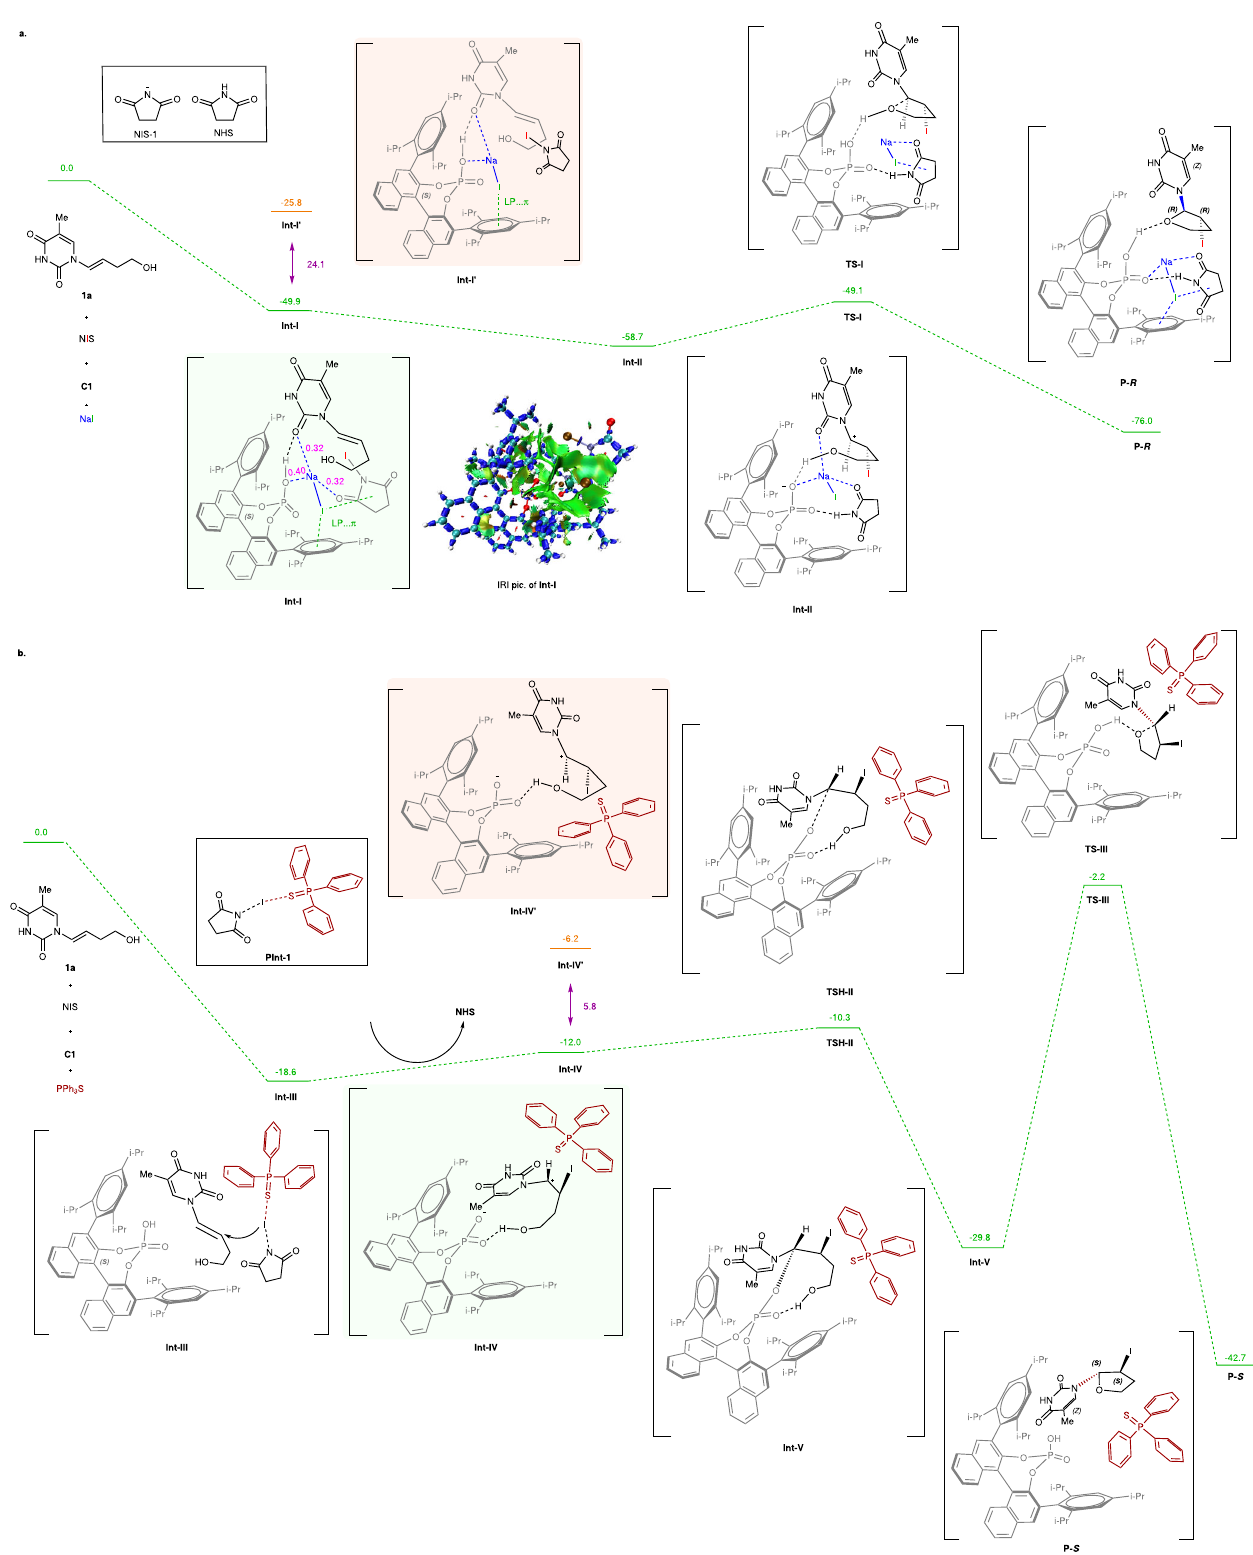
Fig. 8 | The free-energy pro fi le for the additive-controlled asymmetric iodo- cyclizations. a Computational studies of NaI-controlled stereoselective iodocy- clizations ( R -selective/ β -selective conditions). b Computational studies of